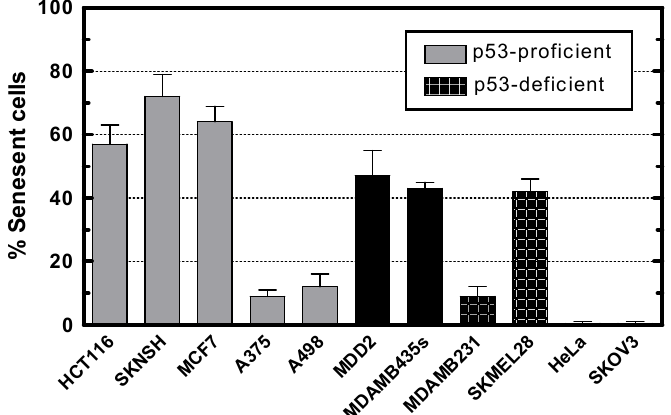
Figure 6. Induction of SIPS in the indicated human cancer cell lines measured at seven days after exposure to an 8-Gy dose of 60 Co γ radiation. All values for irradiated cultures were corrected by subtracting those for sham-irradiated control cultures. Bars, SE. Cell lines marked “p53-proficient” express wild-type p53. Cell lines marked “p53-deficient” are either p53-null (SKOV3 and HeLa) or express mutant p53 (MDD2, MDA-MB-455s, MDA-MB-231, and SKMEL-28). The data for some cell lines are reproduced from our published work [67,131] with